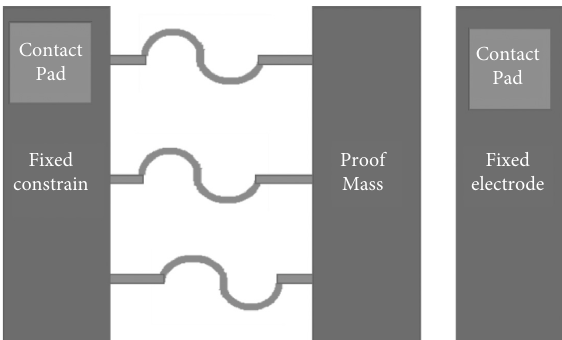
Figure 5: Proposed inertial sensor 5 with three sets of two semicircular beams.